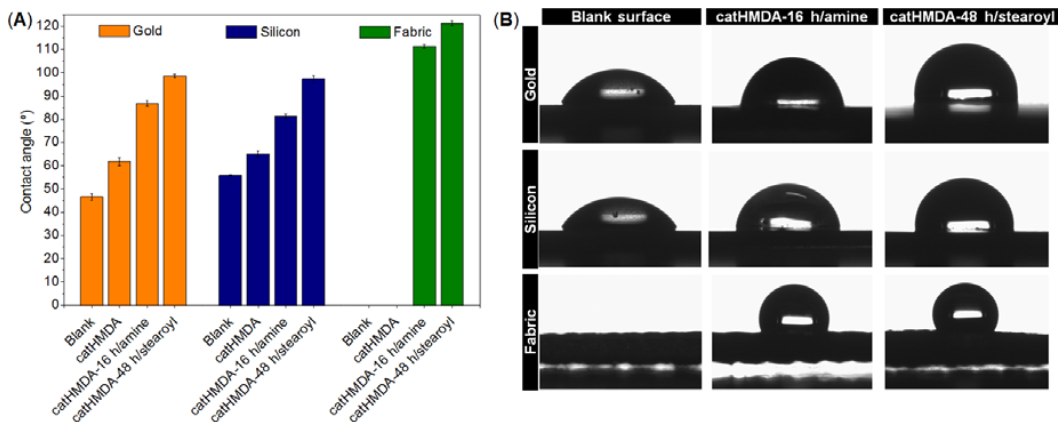
Figure 10. Wettability study after functionalization of catHDMA. ( A ) Contact angles of water on gold, silicon and fabric substrates (blank/uncoated, coated with catHMDA, and coated + functionalized with 1 ‐ hexadecanamine and stearoyl chloride). Data is shown as mean ± standard deviation. ( B ) Images of water droplets on the three substrates before and after functionalization with catHMDA ‐ 16 h/amine and catHMDA ‐ 48 h/stearoyl.